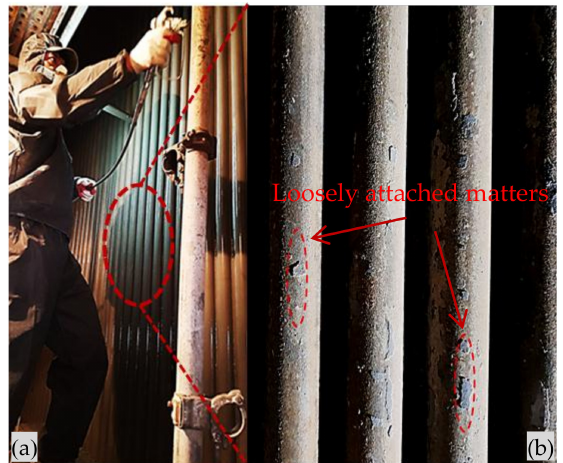
Figure 11. Application of the ceramic coating in real boiler systems: ( a ) slurry spraying process and ( b ) anti-fouling ceramic coating after 3 months operation.